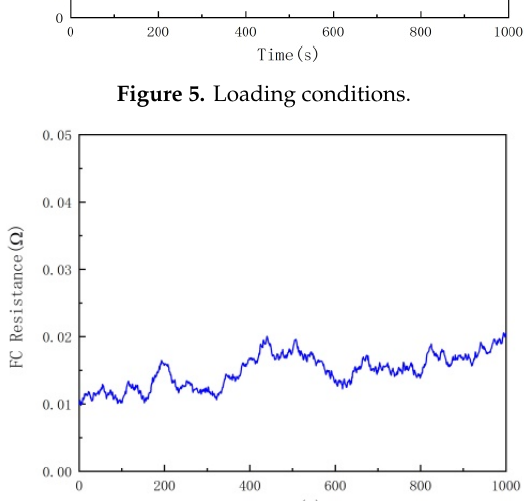
Figure 6. Ohm internal resistance.